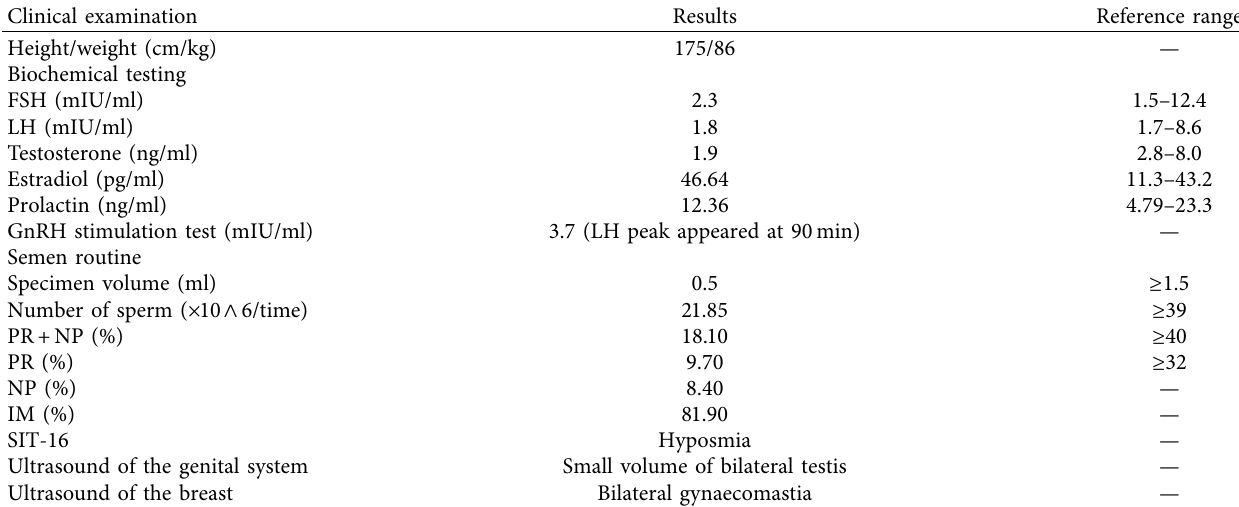
Table 1: The results of auxiliary examination on the KS